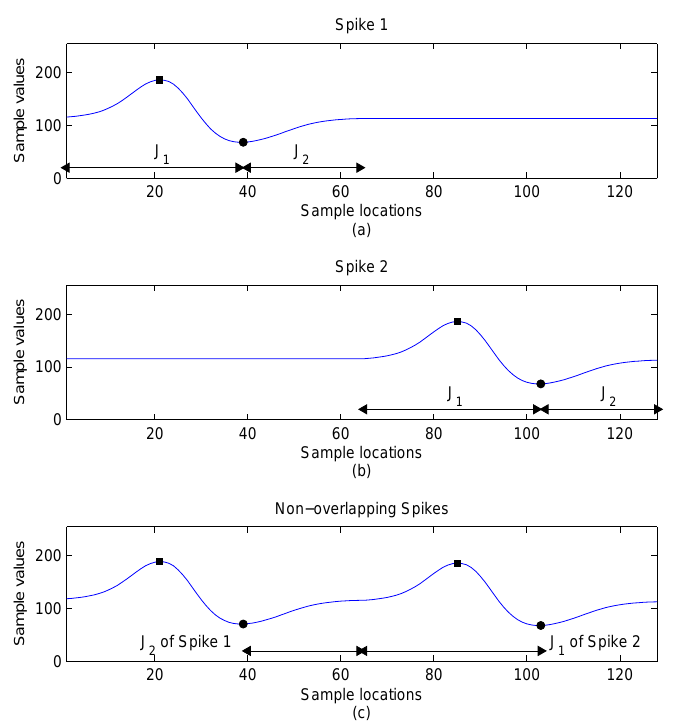
Figure 2. An example of two non-overlapping spikes for feature extraction. ( a ) Original Spike 1; ( b ) original Spike 2; ( c ) resulting waveform after the combination of the two spikes.